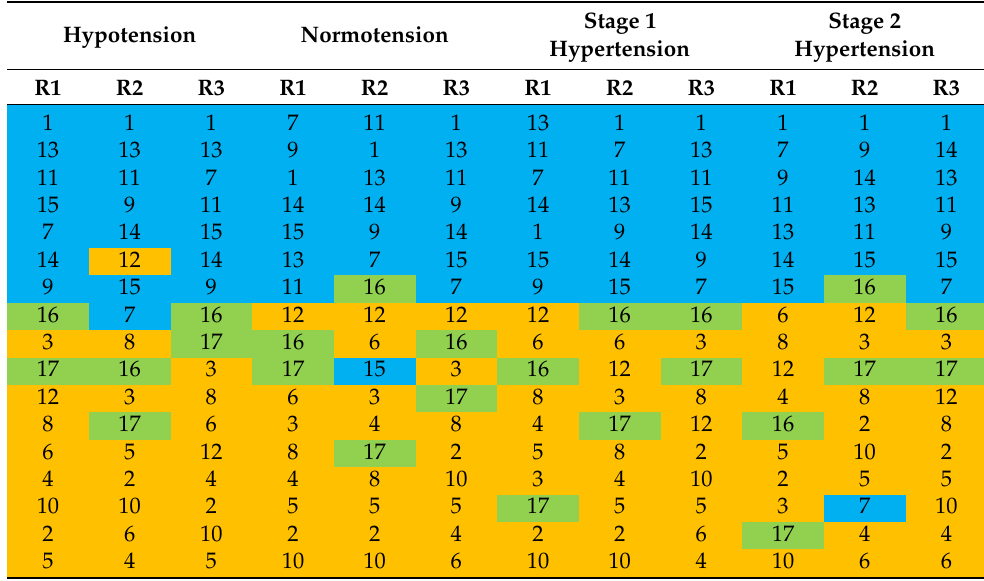
Figure 10. Correlation coefficients ( ρ ) obtained using Spearman correlation analysis for comparing features extracted from infrared and red photoplethysmograms and the contact force of the sensor. The experiment was run three independent times (replicas). Table 5. Ordered features from the lowest | ρ | to the highest | ρ | for features (1 to 17) extracted from infrared PPG signals, in each of the runs of the experiment (R#) and under each blood pressure condition. Features coloured blue indicate temporal features, features coloured yellow indicate amplitude features, and those in green are geometric features reported in